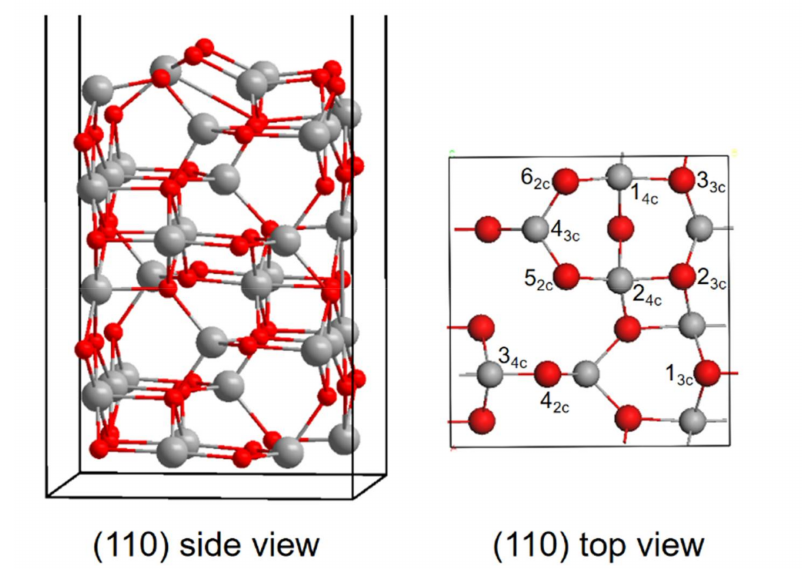
Figure 10. The structures for the γ -Al 2 O 3 (110) surface. O and Al atoms are shown in red and grey, respectively. The exposed top layer atoms re indexed with numbers, and the coordination numbers are shown in